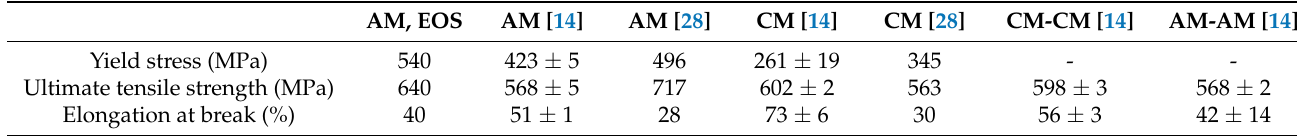
Table 8. Tensile test results in a similar study and supplier values for L-PBF material.